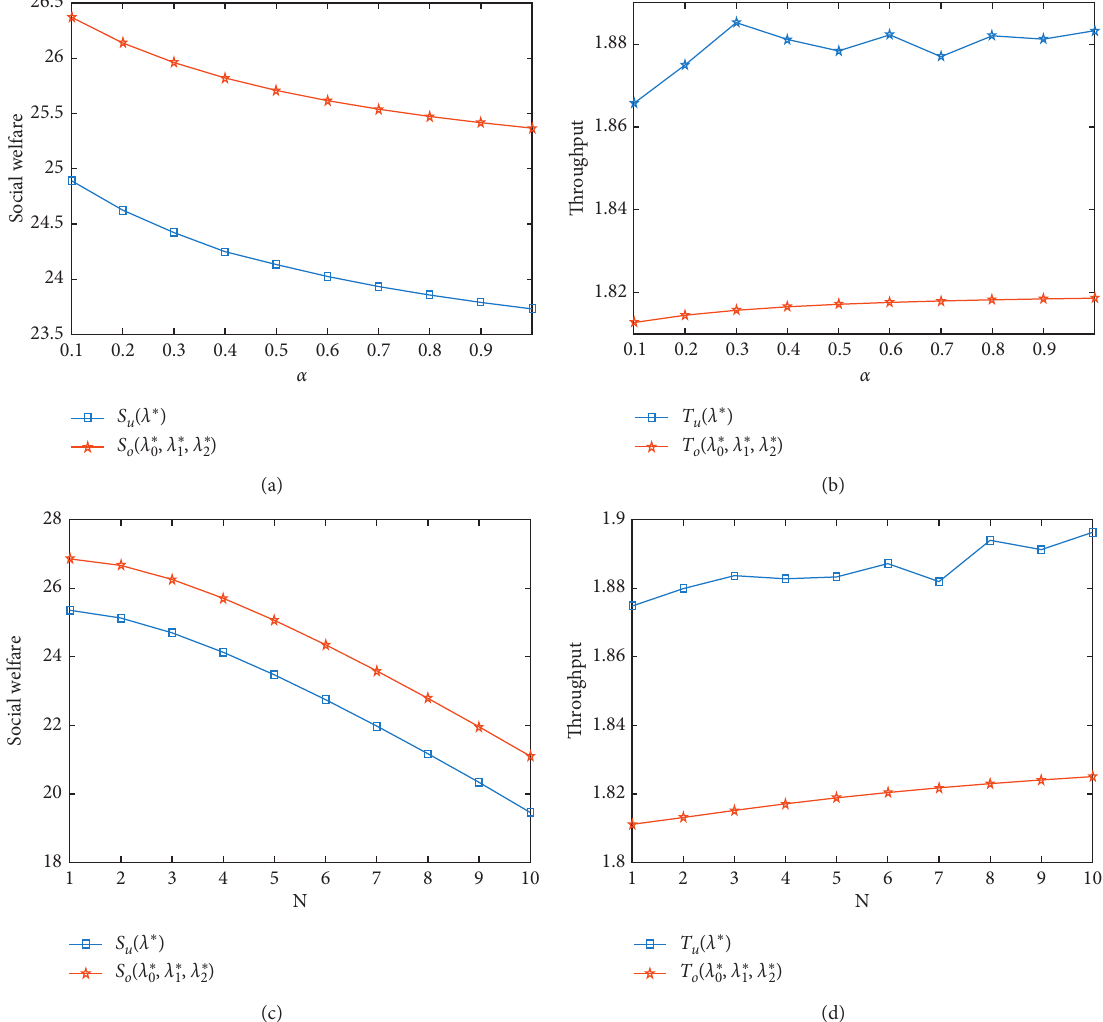
Figure 4: Social welfares S